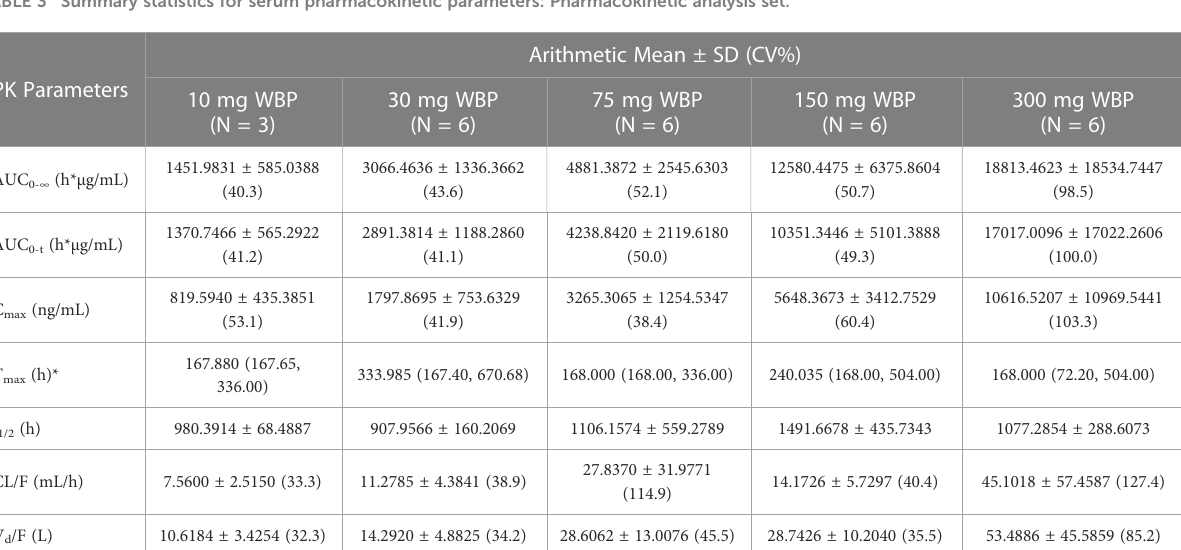
TABLE 3 Summary statistics for serum pharmacokinetic parameters: Pharmacokinetic analysis set.